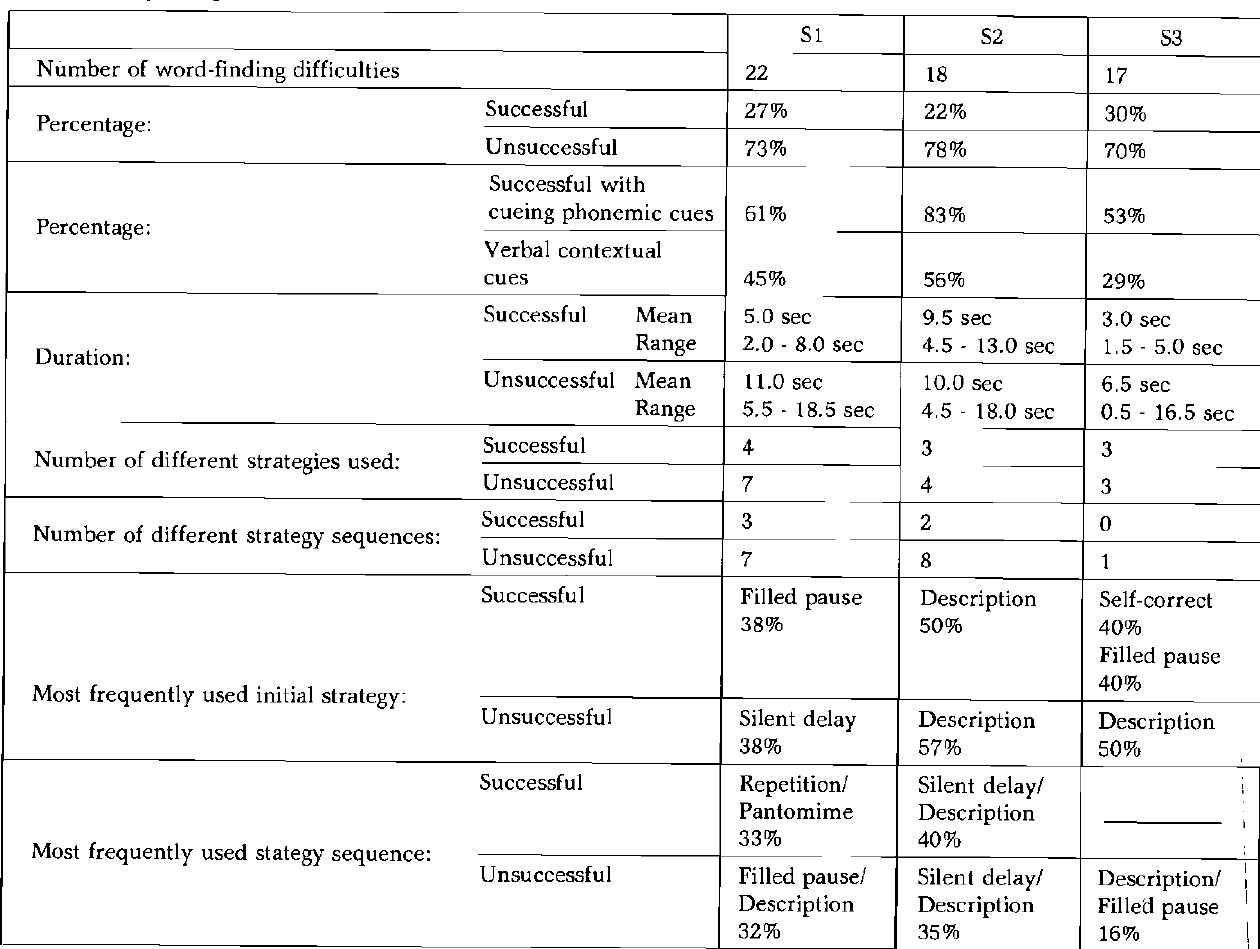
Table 5: Subjects' performance on the